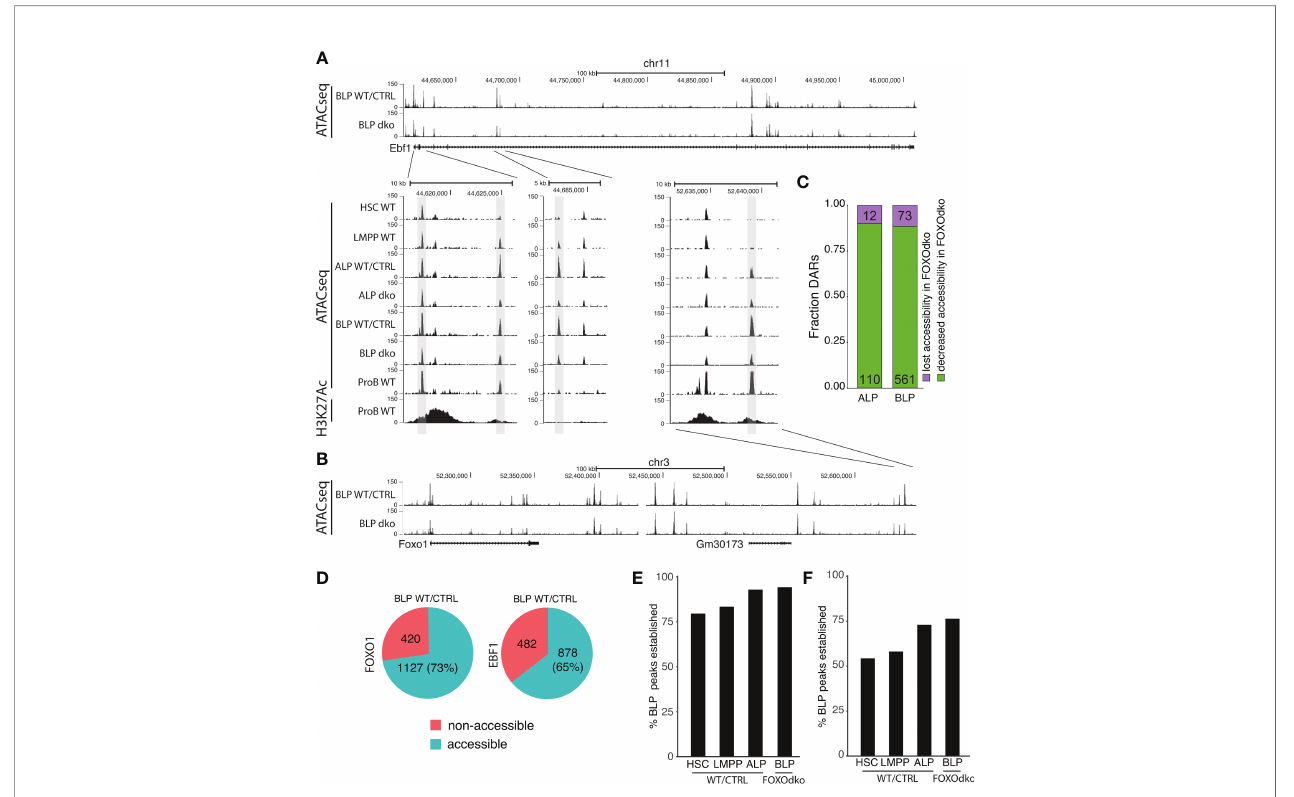
FIGURE 6 | Loss of FOXO is not associated with a failure to establish open chromatin. (A, B) Tracks showing chromatin accessibility (ATACseq) and H3K27Ac (ChIPseq) for indicated cell- and genotypes at the (A) Ebf1 and (B) Foxo1 loci. (C) Fraction of DARs with reduced accessibility displaying either lost or decreased chromatin accessibility in the FOXOdko CLPs. (D) Venn diagram showing the overlap between FOXO1 and EBF1 binding in RAG1ko proB cells and open chromatin in WT/CTRL BLP. (E, F) Percentage of the open chromatin regions (consensus peaks) found in WT/CTRL BLP that overlap with (E) FOXO1 or (F) EBF1 binding and that constitute open chromatin (consensus peaks) at the indicated stages of